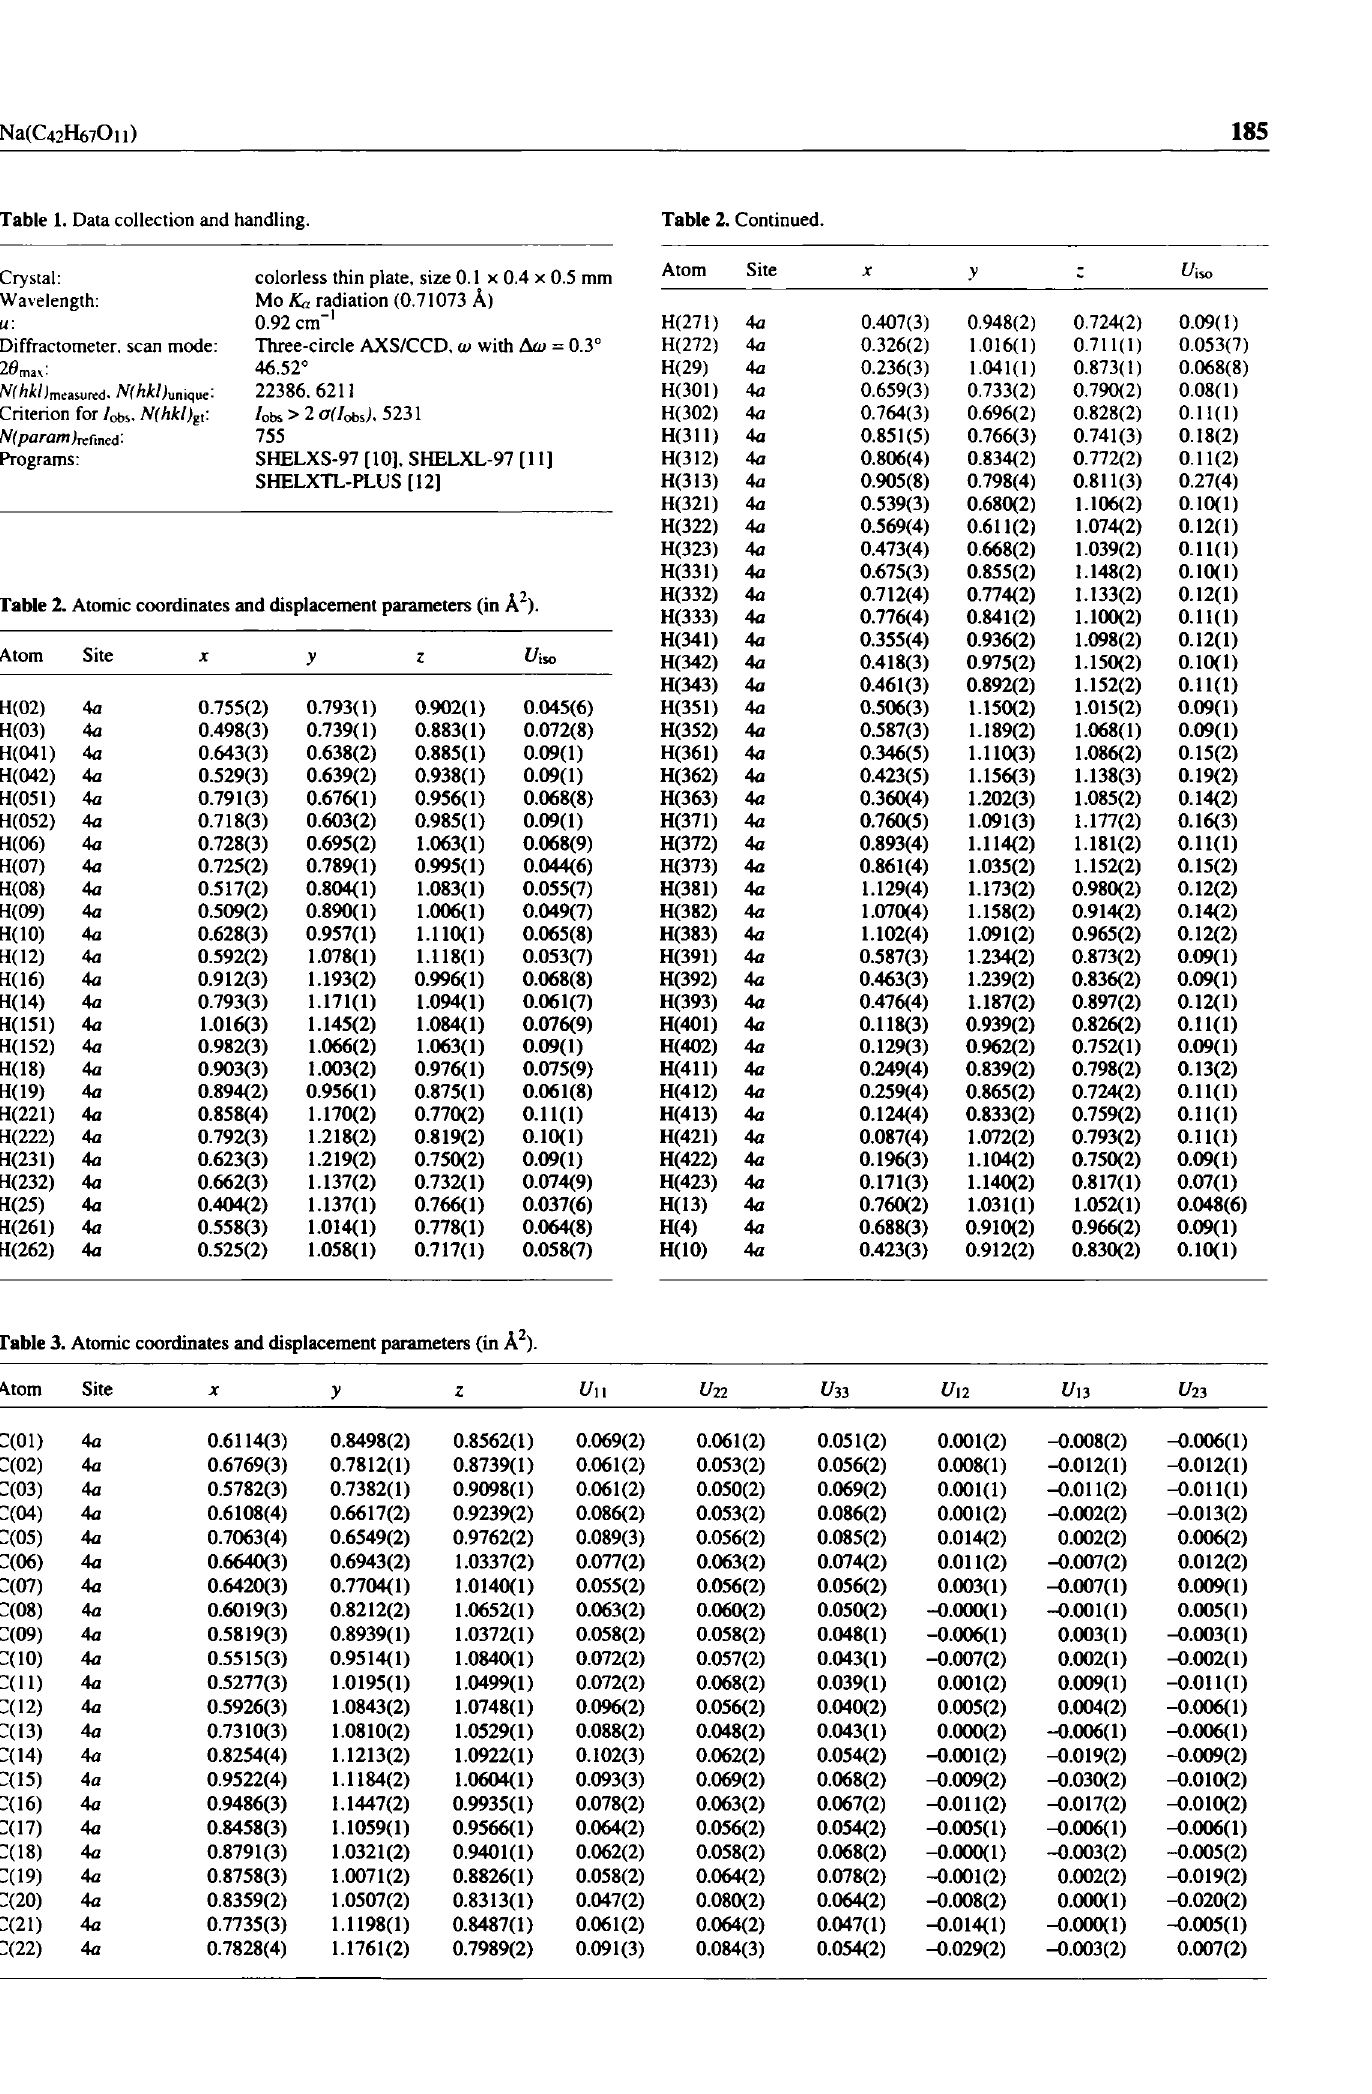
Table 2. Atomic coordinates and displacement parameters (in Â 2 ).